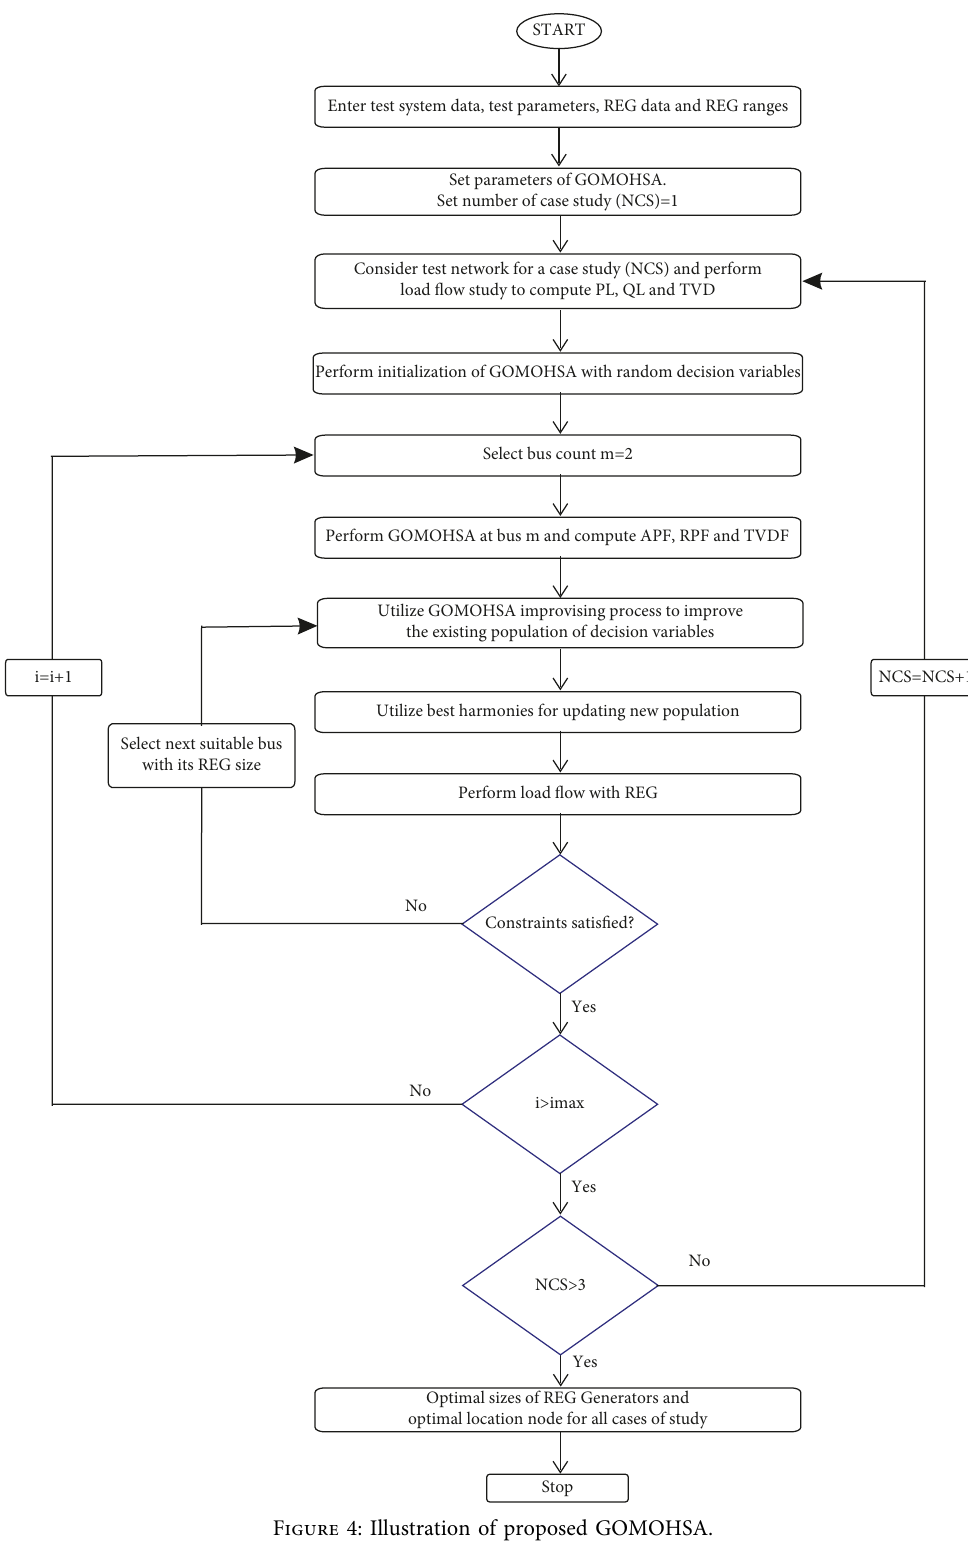
Figure 4: Illustration of proposed